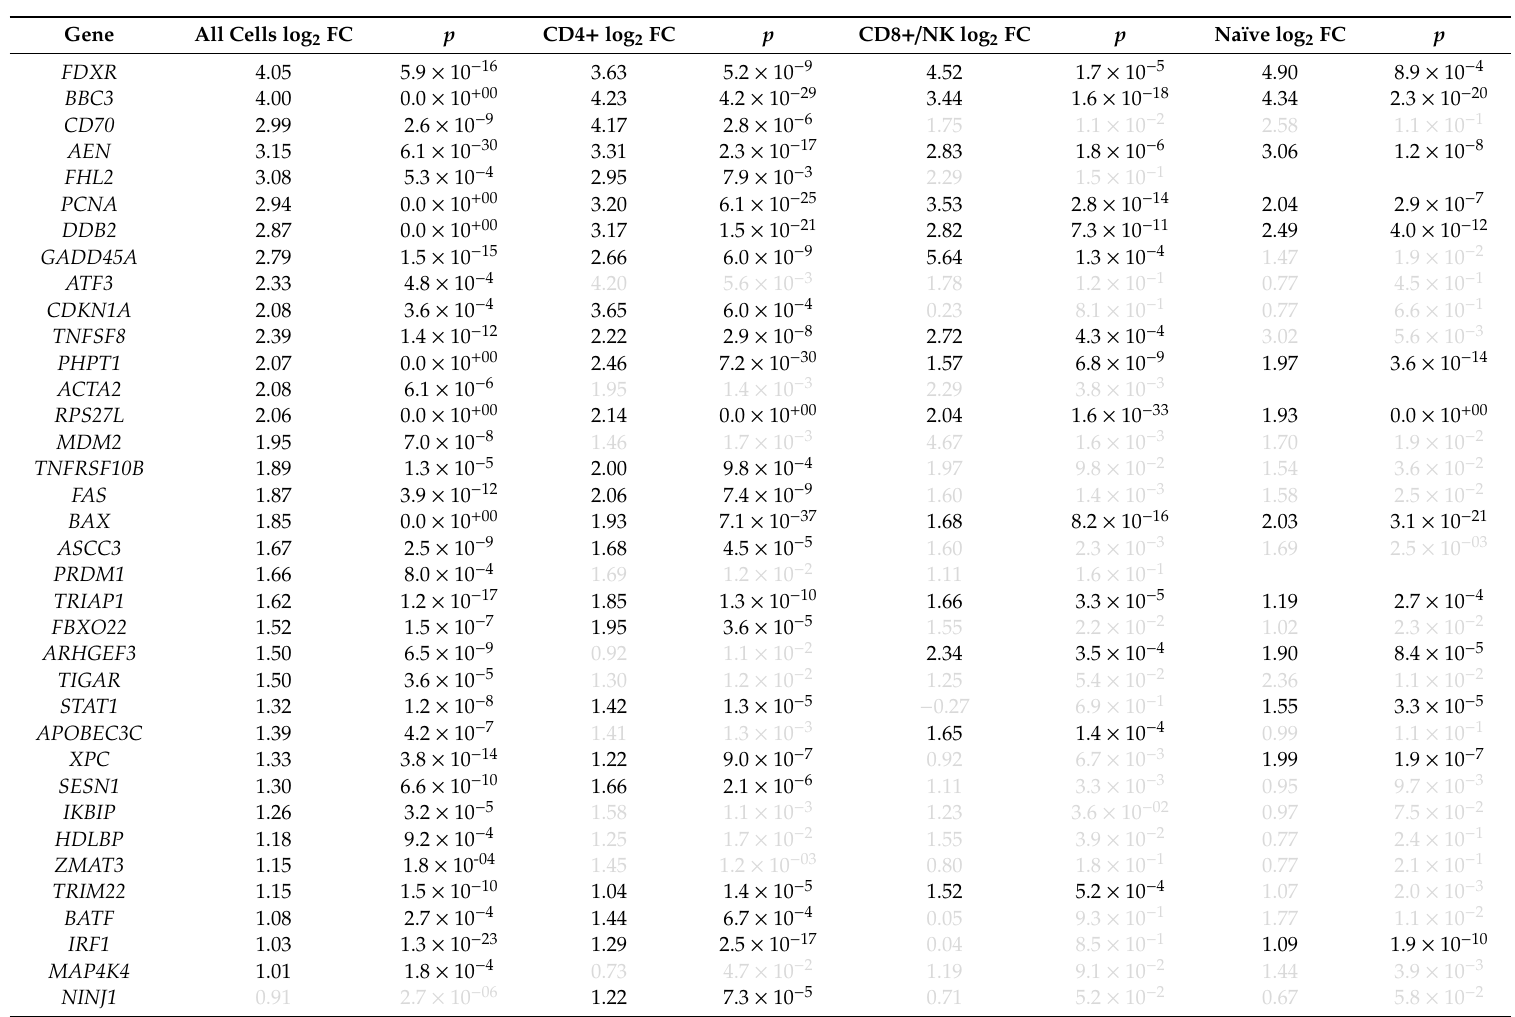
Table 2. Genes whose expressions were upregulated signicantly when all of the cells or cells in individual cell types were considered. The genes meet the criteria of Fold Change (FC) > 2 (log 2 FC > 1) and p <